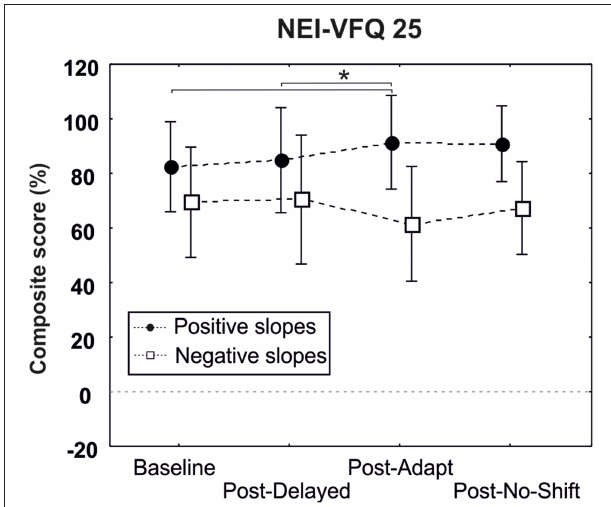
FIGURE 7 | Results of the questionnaire NEI-VFQ25. Composite score of patients with a macular spare superior to 5 ◦ are represented separately for patients having positive (black circles) and negative (white squares) slopes. Bars represent the confident interval at 0.95. Star represents the significant difference of the Baseline (pre-delayed-shift training) and the post-delayed training as compared to the post-adaptation training, as revealed by Post-hoc LSD Fisher test.